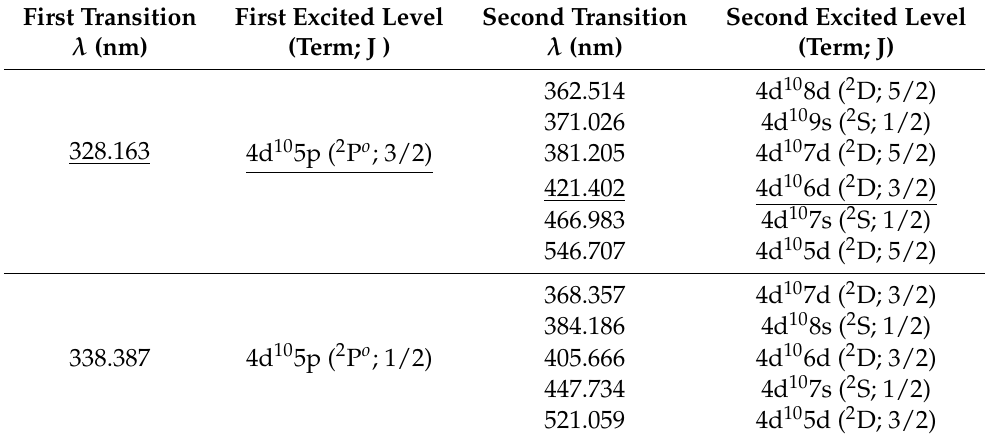
Table 1. Possible resonant photo-ionization schemes of silver; ground state configuration of Ag is 4d 10 5s 2 S 1/2